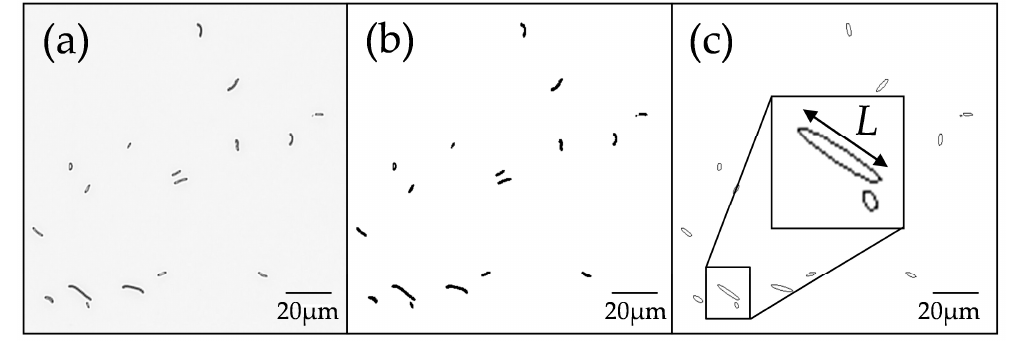
Figure 8. SSD-Image Processing (ImageJ): ( a ) raw microscopy data; ( b ) binary conversion; ( c ) determination of crack length L by best fit ellipse.